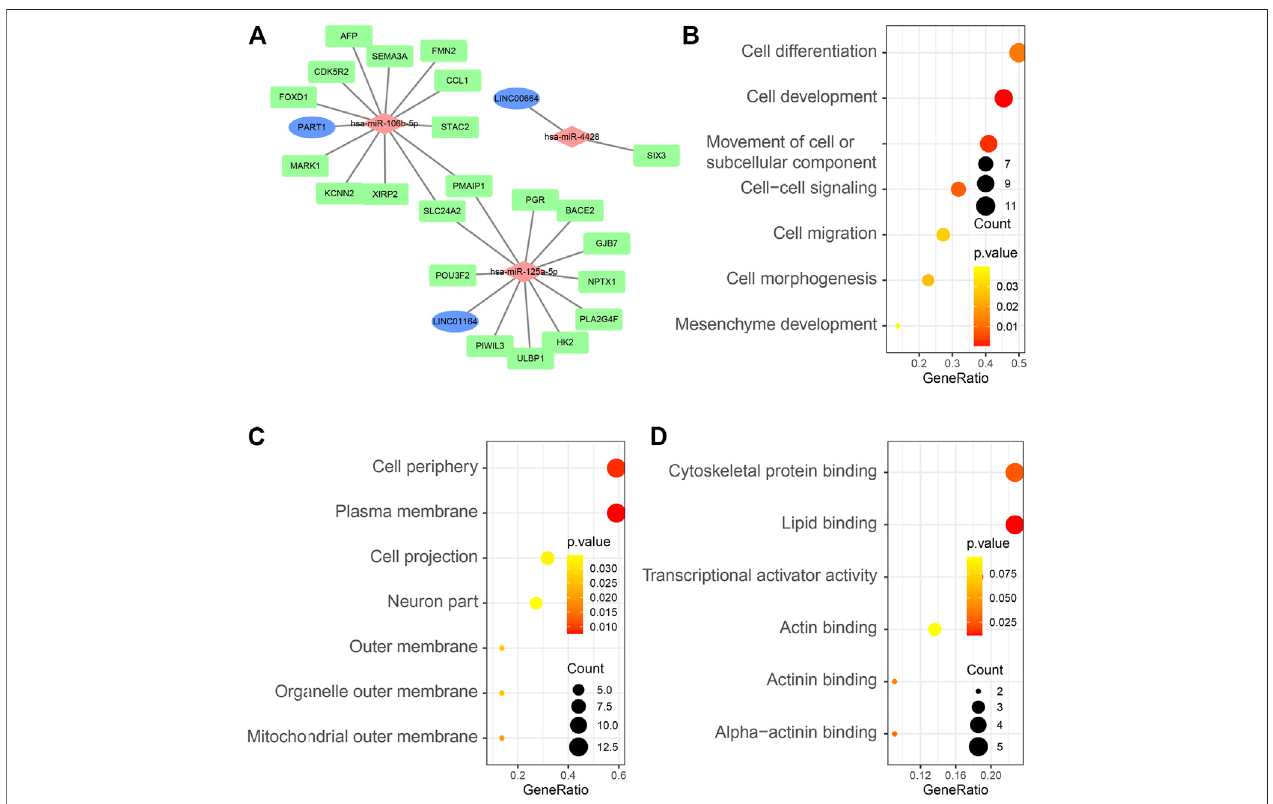
FIGURE3|(A) OverviewofthelncRNA – miRNA – mRNAceRNAnetworkofHCCwiththreelncRNA – miRNApairsand24miRNA – mRNApairs.Blueballsrepresent lncRNAs; red diamonds represent miRNAs and green rectangles represent mRNAs. GO enrichment analysis of 22 DEmRNAs in the ceRNA network: BP terms (B) , CC terms (C) , and MF terms (D)